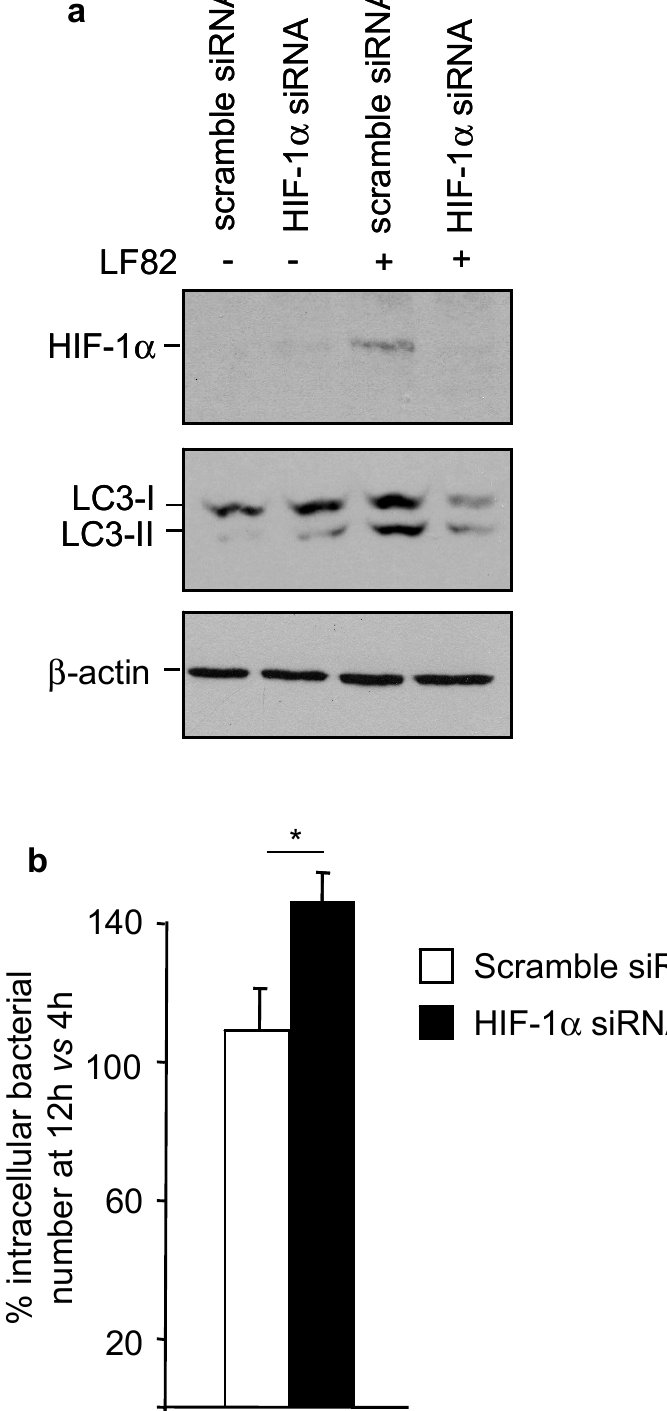
Figure 6. HIF-1 α controls AIEC LF82 intracellular replication by modulating host autophagy. ( a , b ) T84 cells were transfected with 50 nM of HIF-1 α siRNA or a scramble siRNA for 24 h and then infected or not with the wild-type AIEC LF82 strain for 3 h. Cells were washed and then incubated with gentamicin. ( a ) Expression levels of HIF-1 α and LC3 were analyzed by Western blot at 6 h (3 h infection + 3 h with gentamicin) post-infection. ( b ) The number of intracellular LF82 was counted on LB agar plates and is presented as the ratio of intracellular bacteria at 12 h (3 h infection + 9 h in gentamicin) compared to 4 h (3 h infection + 1 h in gentamicin) post-infection. Data are means ± SEM of six replicates and are representative of two independent experiments. * p < 0.05 by Mann–Whitney test.